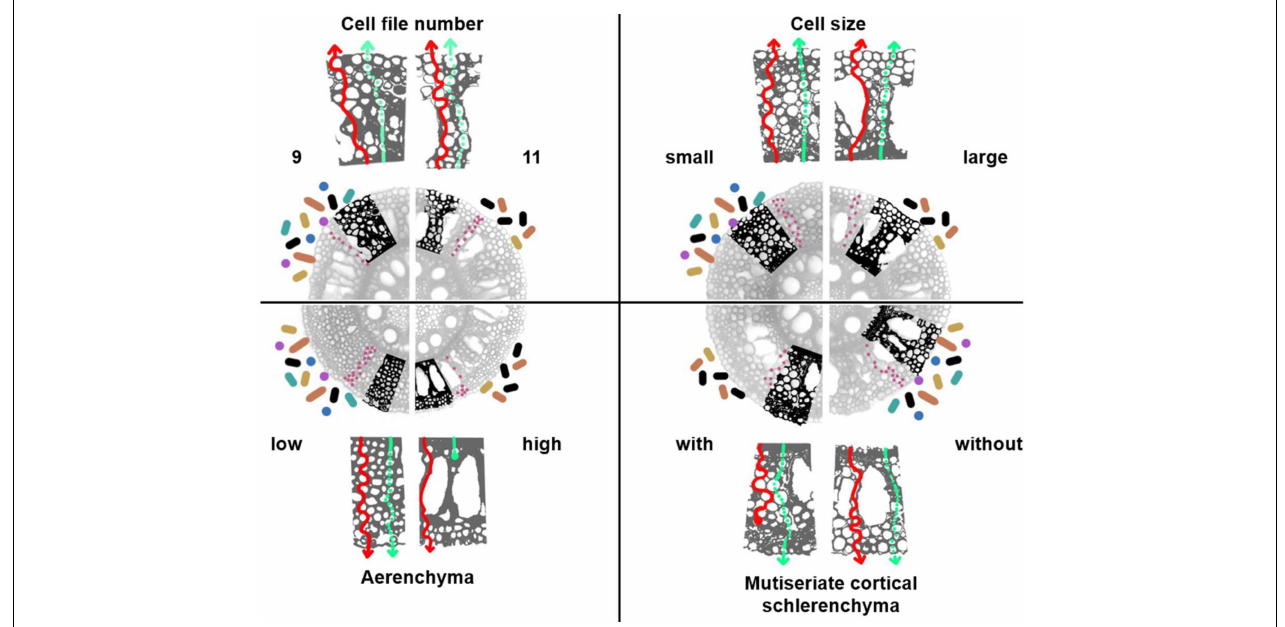
FIGURE 3 | Hypothesized rhizosphere and endosphere microbiome interactions with the root anatomy of a cereal. Images of root cross-sections of maize axial roots and detail (bolded excerpt) of the expected changes in root exudation from the apoplastic (red solid arrows) or symplastic pathway (green dashed arrows). Four phenotypes are depicted: cell file number (9 vs. 11), which indicates the number of concentric cell layers in the cortex; RCA (low vs. high), the production of air pockets in the cortical tissue; cell size (small vs. large); MCS (with vs. without), lignified schlerenchyma in the peripheral cortical tissue. We propose that each of these phenotypes has an associated pattern of root exudation that may affect rhizosphere (icons indicated with colored circles and bastons around the roots) and endosphere (pink circles in the root cortex) microbial communities. Although not to real scale, the quantity of the microbe icons indicates our proposed hypotheses on microbial abundance. Colors in the rhizososphere microbe-icons indicate our proposed hypothesis about effect of root anatomy on biodiversity, with more colors indicating increased species or functional